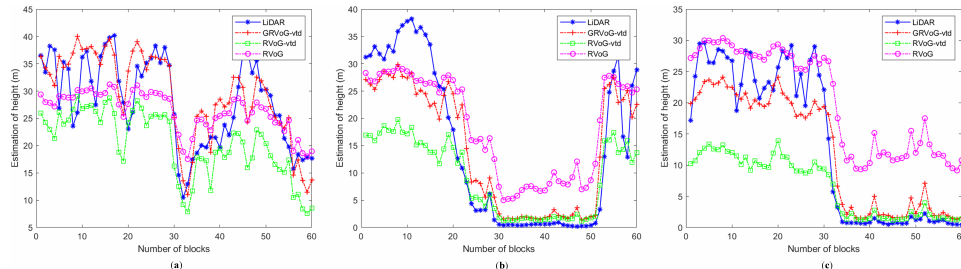
Figure 13. The line views of the estimation of vegetation heights. ( a – c ) are three vertical lines distributed in the left, middle and right parts of the image with the column number 25, 500 and 975,